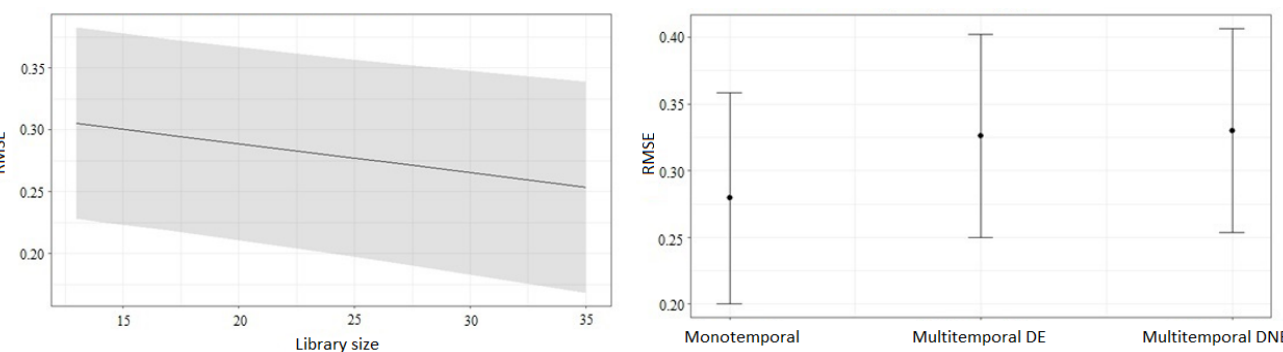
Figure 7. The panel on the left shows the mean predicted RMSE values (±95% confidence intervals) depending on library size: the abscissa axis reflects the number of spectral signatures as the size of the spectral library, and the ordinate axis represents the predicted RMSE value. The panel on the right shows the mean predicted RMSE values (±95% confidence intervals) depending on library type: the abscissa axis reflects the type of spectral library (monotemporal, multitemporal with equitable distribution (Multitemporal_DE), or multitemporal with inequitable distribution (Multitemporal_DNE)).